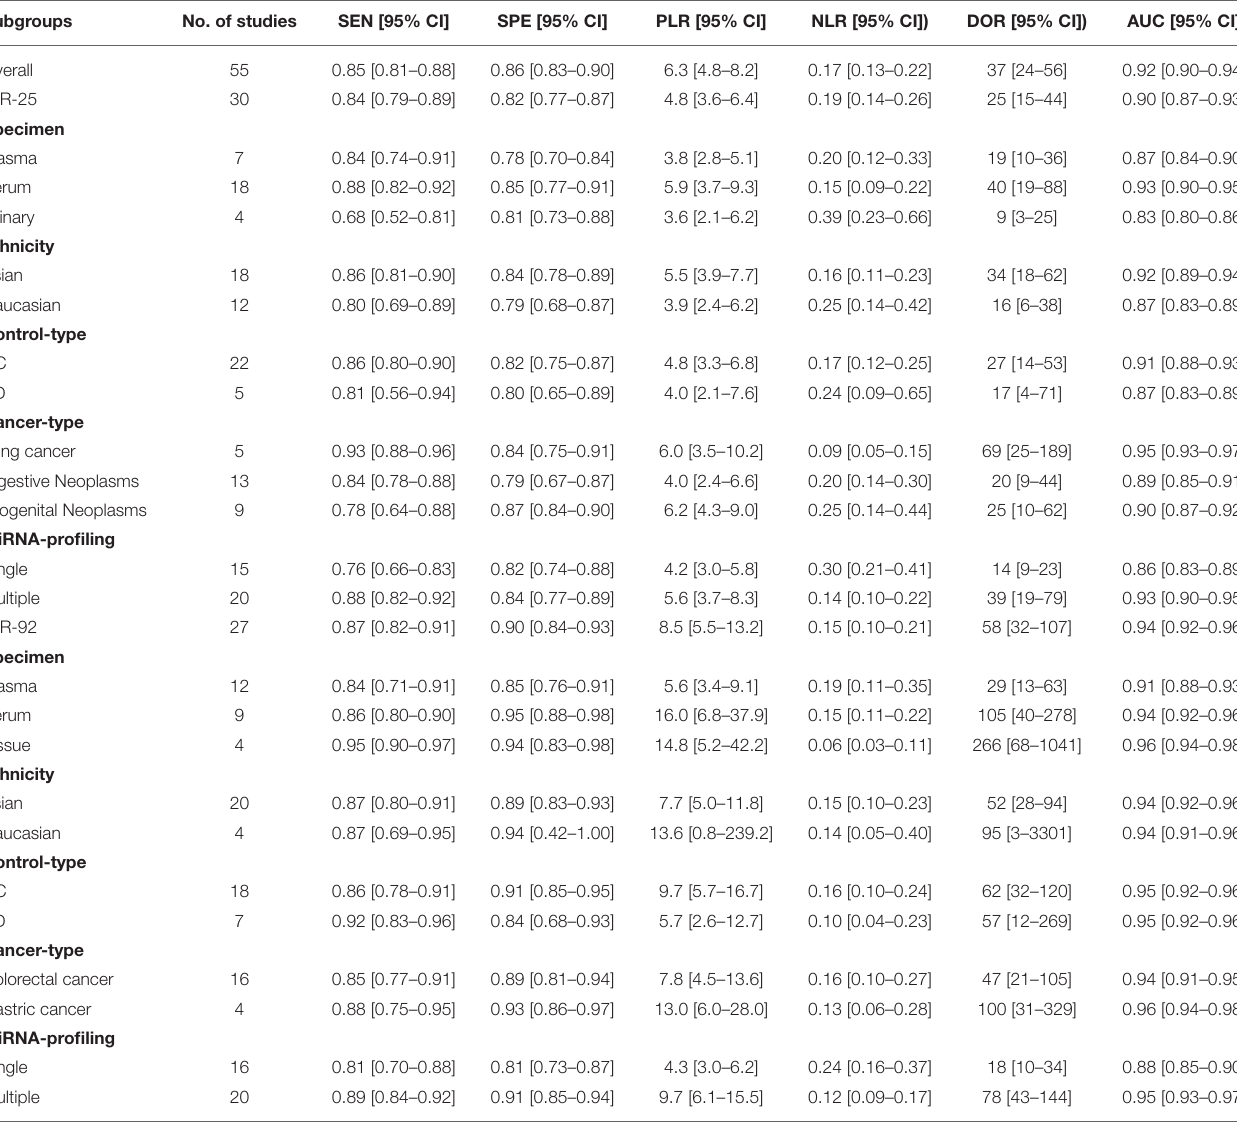
TABLE 1 | The overall and subgroup diagnostic